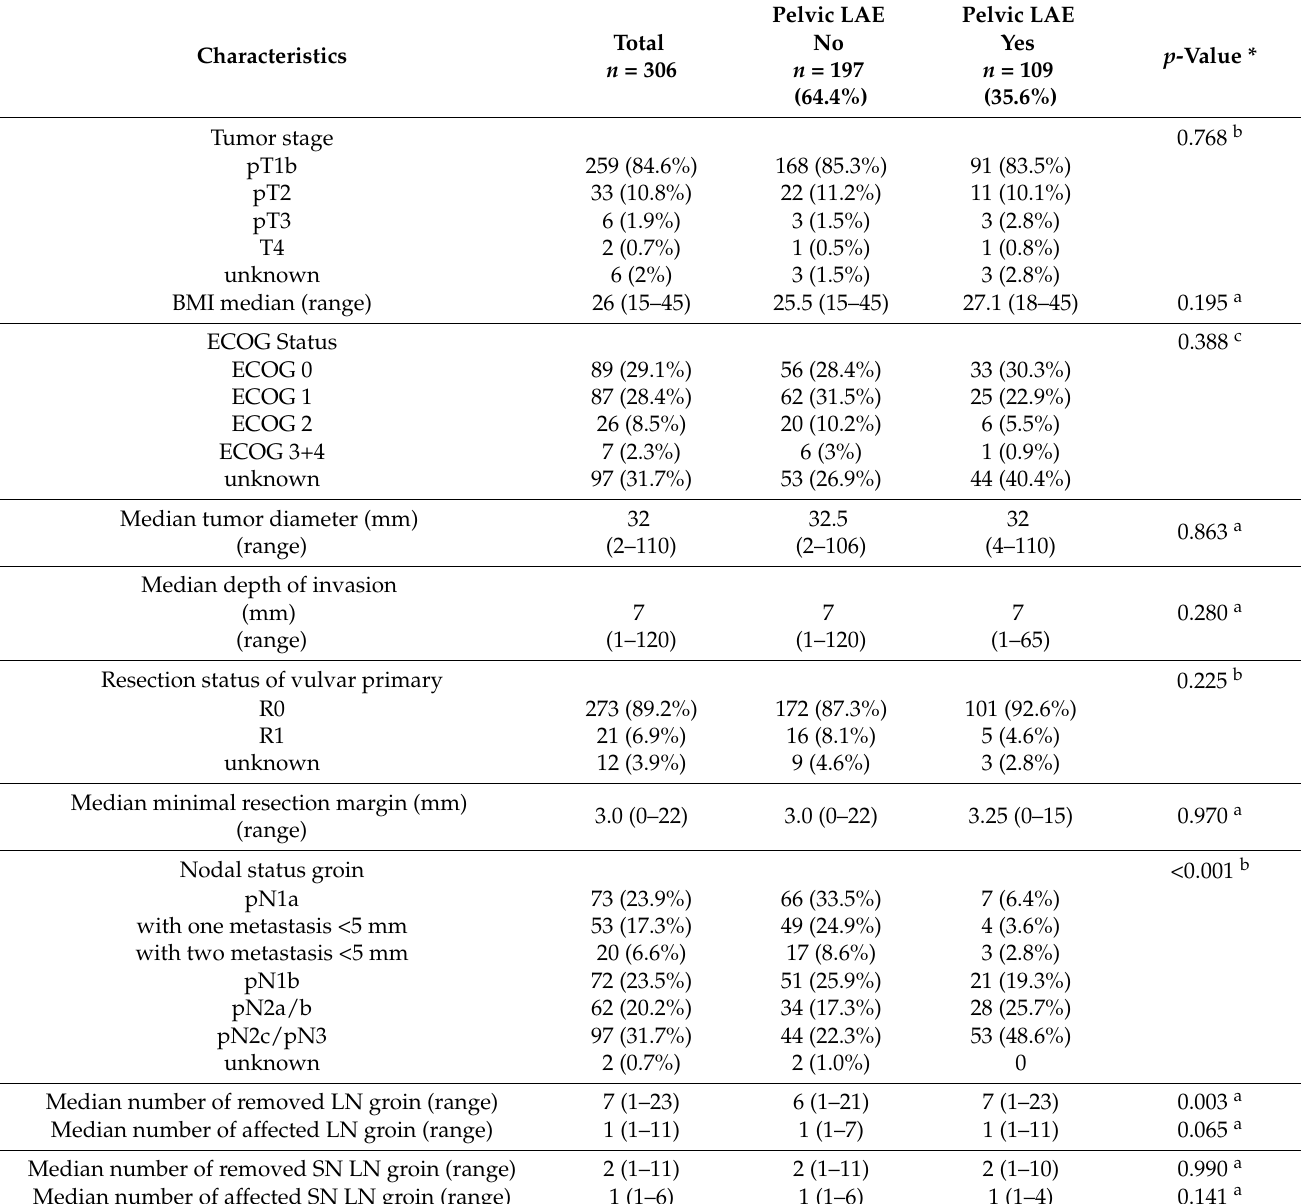
Table 1. Patient characteristics ( n = 306) with regard to surgical